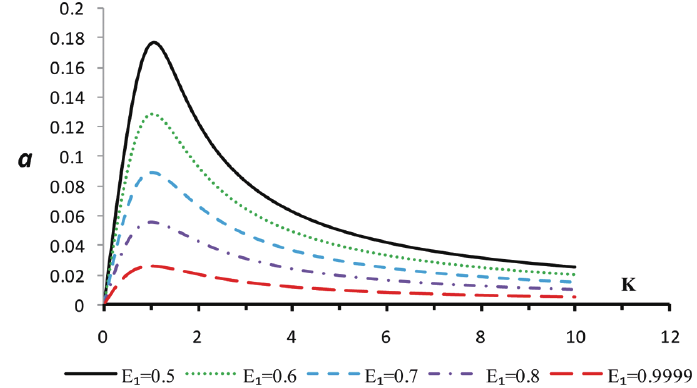
Fig. 3. Variations of a in terms of K for different values E 1 .